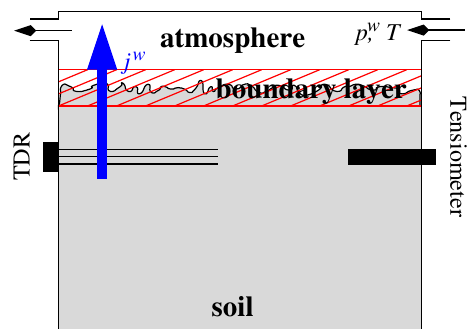
Fig. 1. Sketch of the experimental setup. Evaporation takes place into a gas-tight head space above the soil surface. Air is flowing through it to remove the water. Water vapour molar fraction and temperature in the head space is controlled to define the boundary condition. The water flux is measured by the difference in vapour content of the incoming and outgoing air in a controlled gas